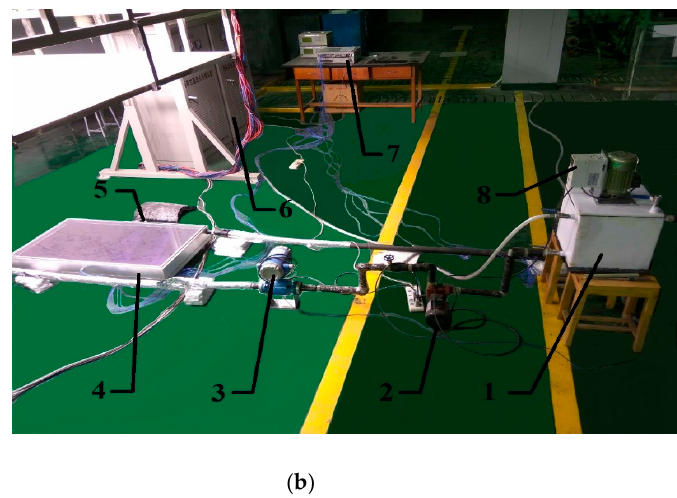
Figure 2. Schematic diagram and picture of Solar water heating system. ( a ) Schematic diagram; ( b ) picture.